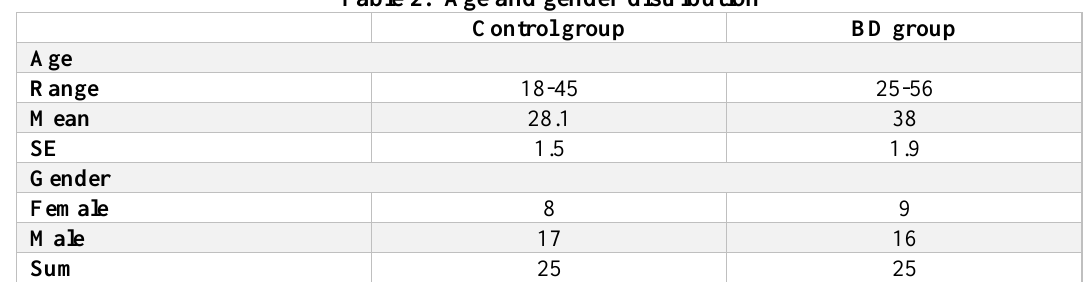
Table 2: Age and gender distribution